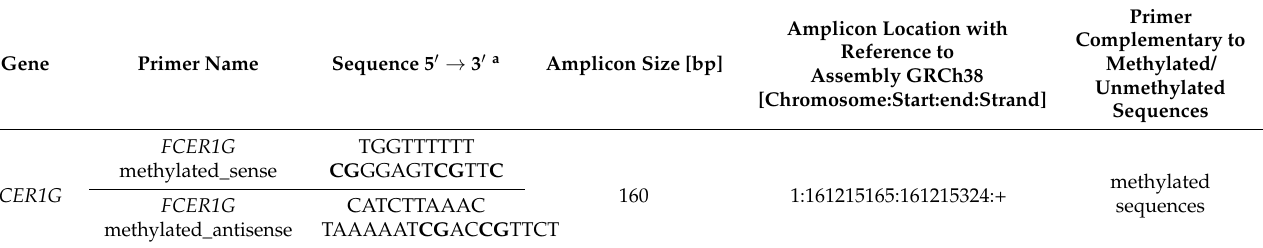
Table 3. Characteristics of